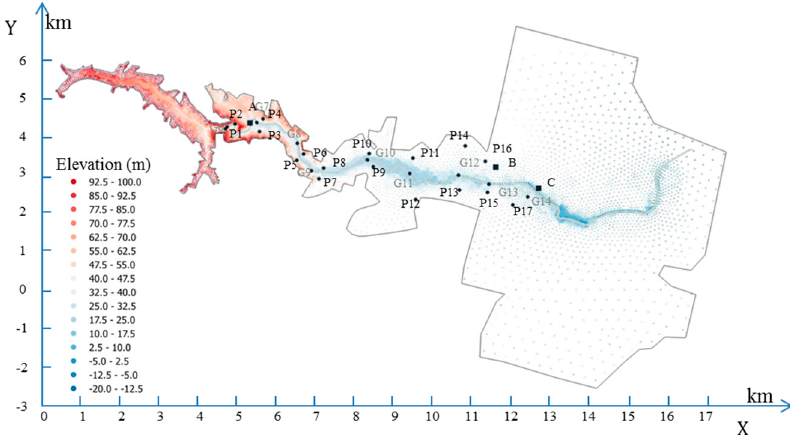
Figure 1. Map of the region under investigation in a local coordinate system. The points surveyed by the police after the dam break are indicated as Pi with i = 1,…,17, while the gauge points of the laboratory ‐ scale model built in the National Hydraulic and Environment Laboratory of EDF [8,46] are indicated as Gi with i = 1,…,14. A, B and C are the Electrical Transformers (ETs) of three hydroelectric plants placed along the river.